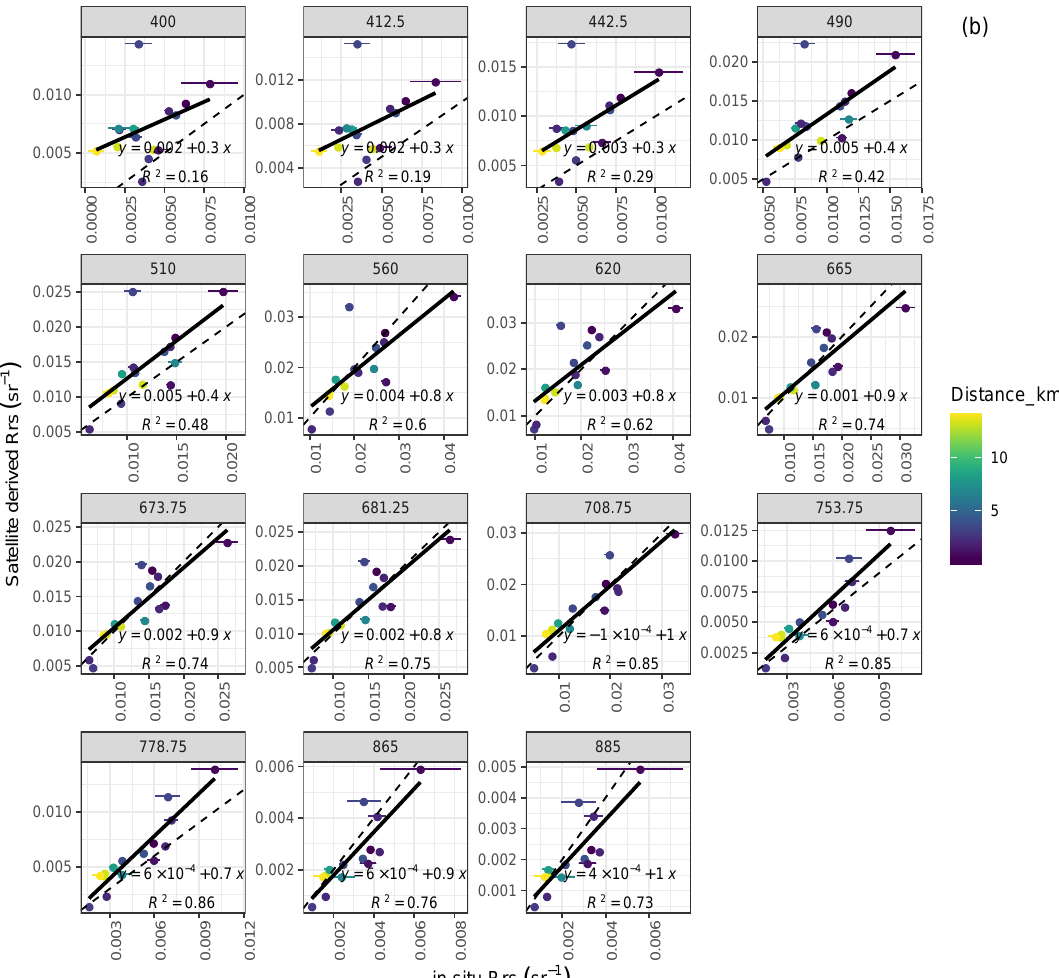
Figure A4. Correlation between in situ measured ( x -axis) vs. C2RCC-derived rho ( y -axis) on OLCI bands. Upper figure ( a ) shows validation results on all data and lower ( b ) after filtering the in situ data based on the 5% criteria at least in one band. For each match-up point, the color shows the distance from the